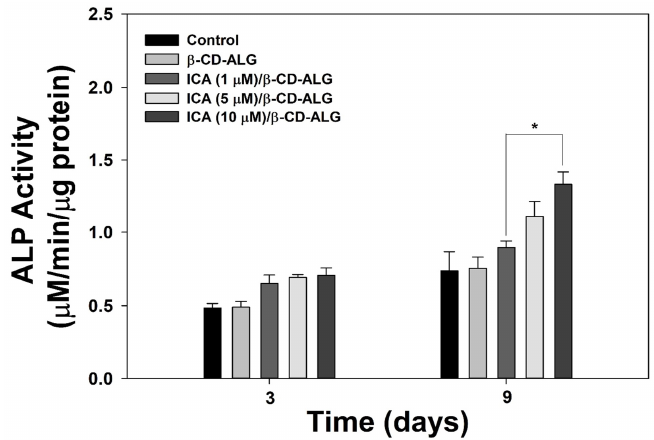
Figure 6. Analyses of ALP levels of MC3T3-E1 cells incubated with β -CD-ALG, ICA (1 µ M) / β -CD-ALG, ICA (5 µ M) / β -CD-ALG, and ICA (10 µ M) / β -CD-ALG after 3 and 9 days of incubation (n = 4). * p < 0.05.